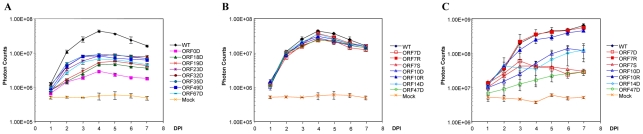
Growth curve analysis of some VZV deletion mutants.A. Eight VZV ORF deletion mutants showing slow growth kinetics in cultured MeWo cells. One hundred PFU of each deletion mutant and VZVLuc (WT) were infected with MeWo cells in 6-well dishes in triplicate. Bioluminescence was measured using the IVIS system every day for 7 days after D-luciferin was applied to the cultured media. Total Photon Count in each well (photons/sec/cm2/steradian) was measured, and the values from the triplicate results were averaged. The growth curves were generated when averaged photon counts for each day were plotted. Error bars represent standard deviation for three replicates. B. In vitro growth curve analysis of VZV ORF7, ORF10, and ORF47 mutant viruses. One hundred PFU of ORF7 and ORF10 mutant and rescue (ORF7D, ORF7S, ORF7R, ORF10D, and ORF10R) and ORF47 deletion virus (ORF47D) from infected MeWo cells were used to infect 50% confluent MeWos seeded in 6-well dishes. Experiments were performed in triplicates. The growth curves were generated as described in A. C. Growth curve analysis of VZV ORF7, ORF10, and ORF47 mutants in human fetal skin organ cultures. Skin tissues were inoculated with 5×103 PFU VZVLuc or other VZV variants, as indicated. VZV replication was monitored daily by IVIS for one week as bioluminescence emitting from each skin culture was measured. Each line represents an average of the data from 3 different skin tissue samples, all infected with the same virus. D-luciferin was also applied to three uninfected skin tissue samples (injected with PBS) as mock infection.